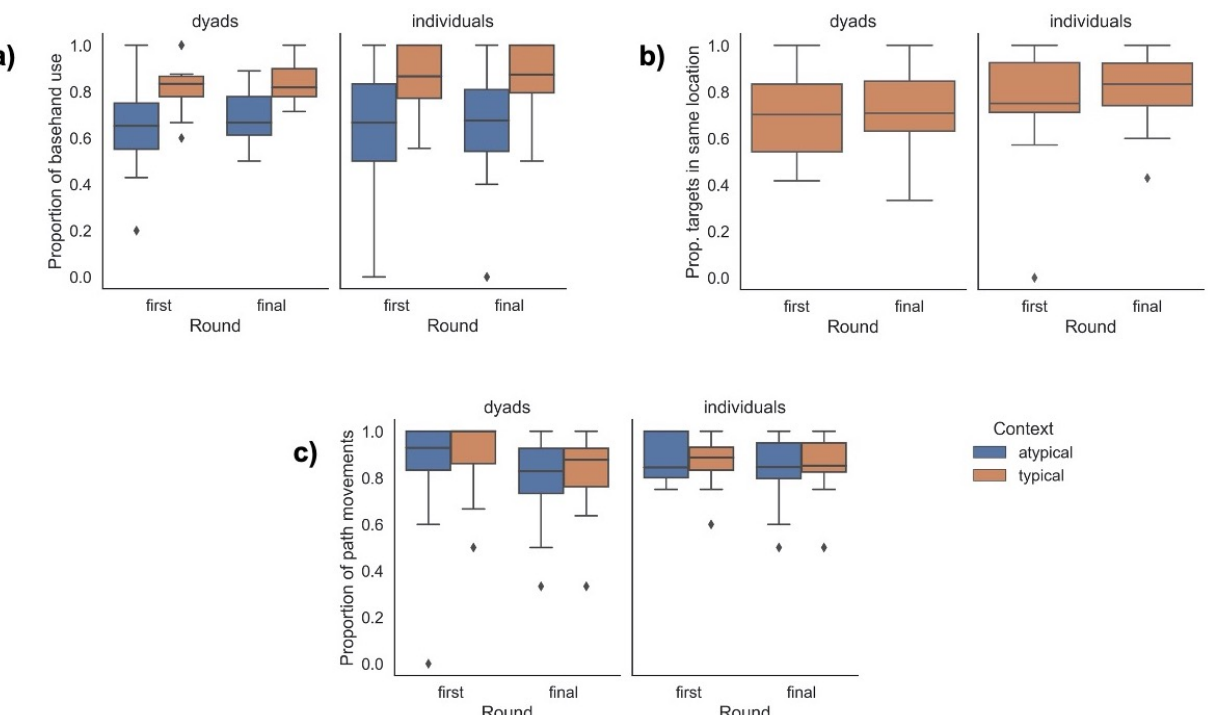
Figure 10. Gesture form analyses for experiment 2, showing base hand use ( a ), proportion of target action gestures produced in the same location for typical and atypical contexts ( b ), and gesture size ( c ) for both dyads and individuals.